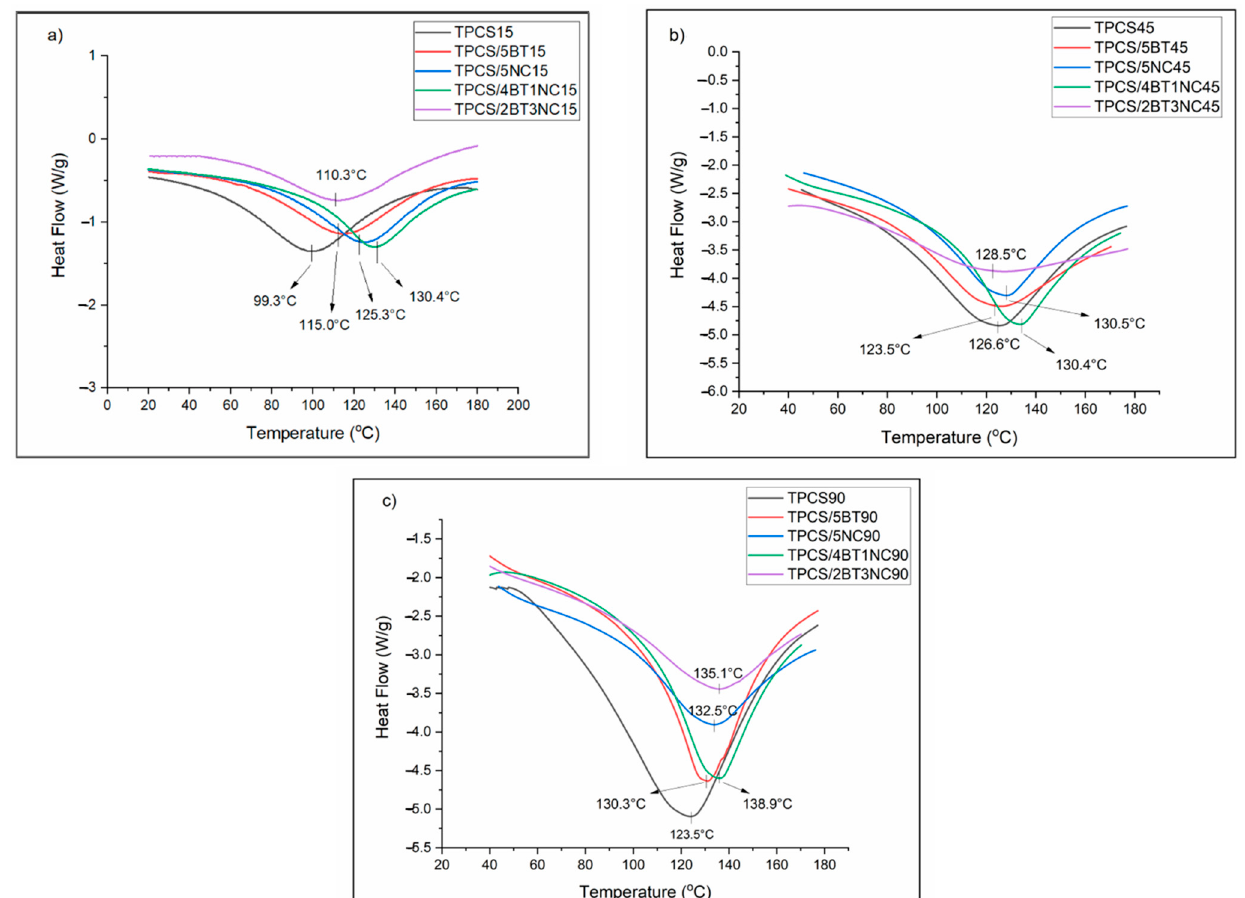
Figure 3. DSC heating curves of virgin TPCS, TPCS-C, and TPCS-HC films aged for ( a ) 15, ( b ) 45, and ( c ) 90 days.